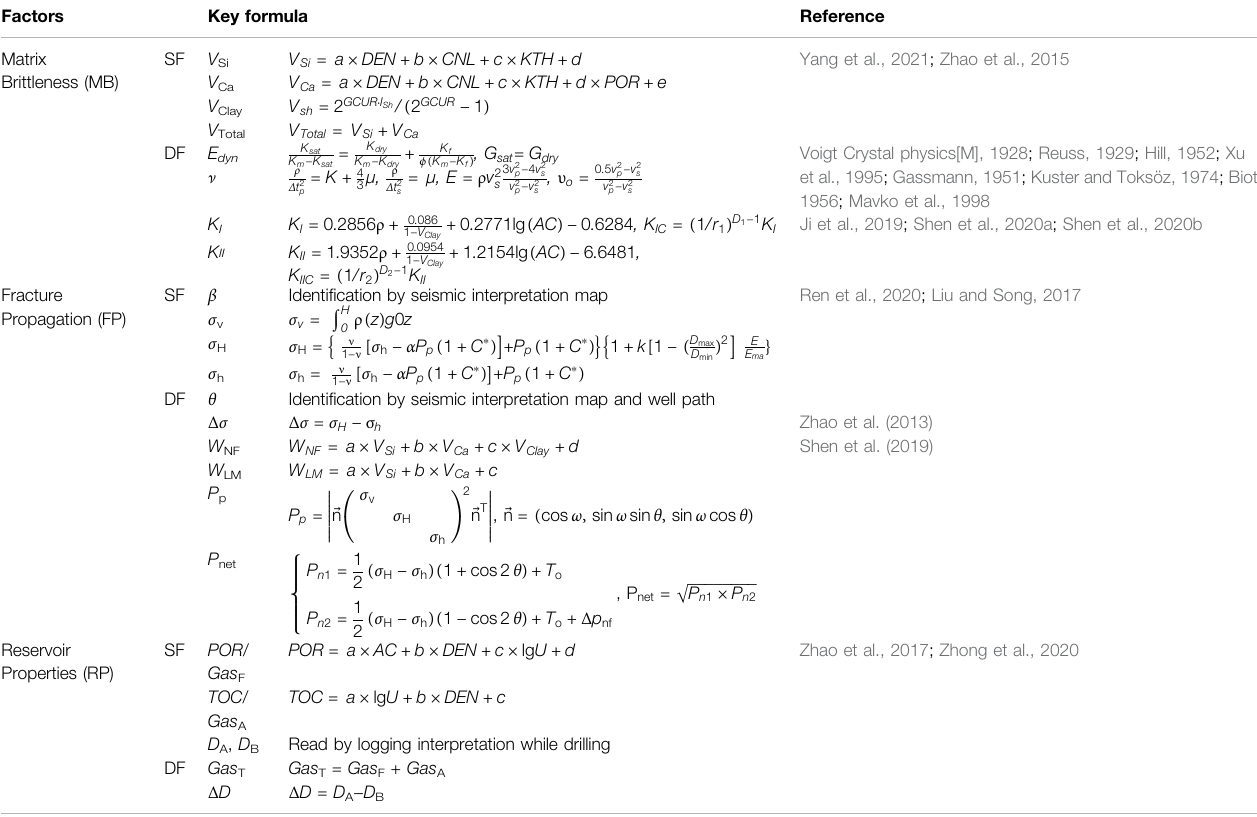
TABLE 1 | Stimulation effect in fl uencing factors and their calculating formulas. Factors Key